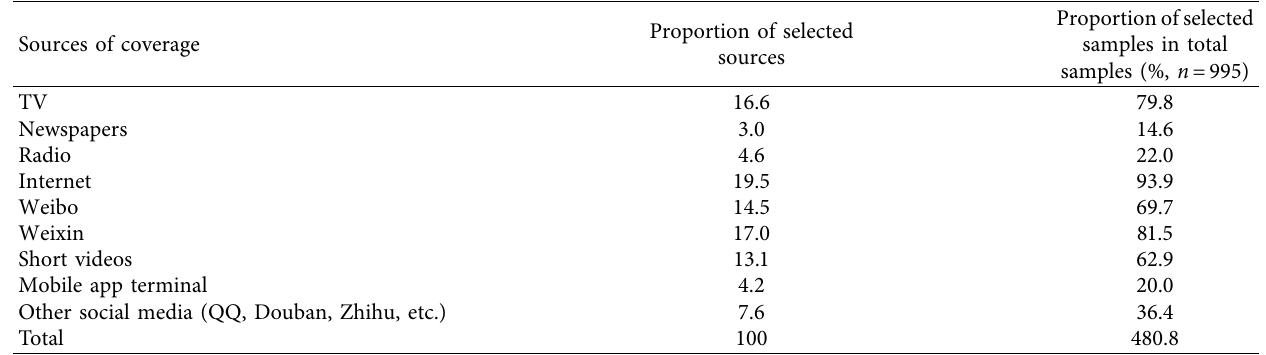
Table 5: Sources of news media coverage on COVID-19 vaccines.